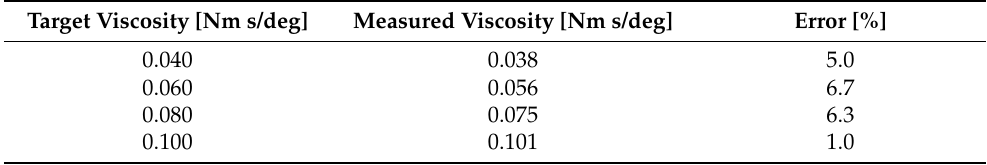
Table 2. The measured value for joint viscosity command value.